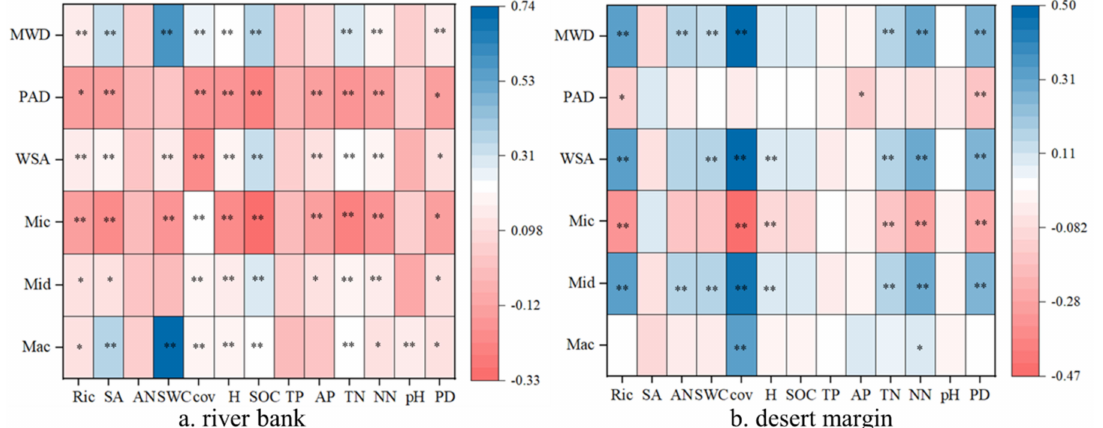
Figure 4. The correlation between vegetation and soil characteristics and soil stability in different communities. Note: MWD, PAD, and WSR represent mean weight diameter, the percentage of soil aggregates with a particle size larger than 0.25 mm, and the percentage of aggregate destruction, respectively. Mac, Mid, and Mic represent soil macro-aggregates, intermediate aggregates, and micro- aggregates, respectively. Ric, SA, AN, SWC, cov, H, SOC, TP, AP, TN, NN, pH, and PD represent species richness, soil salinity, ammonium nitrogen, soil water content, plant coverage, plant height, organic carbon, total phosphorus, available phosphorus, total nitrogen, nitrate nitrogen, soil acidity and alkalinity, and plant phylogenetic richness, respectively. * and ** represent p < 0.05 and p < 0.01, respectively. The blue grid represents a positive correlation and the red grid represents a negative